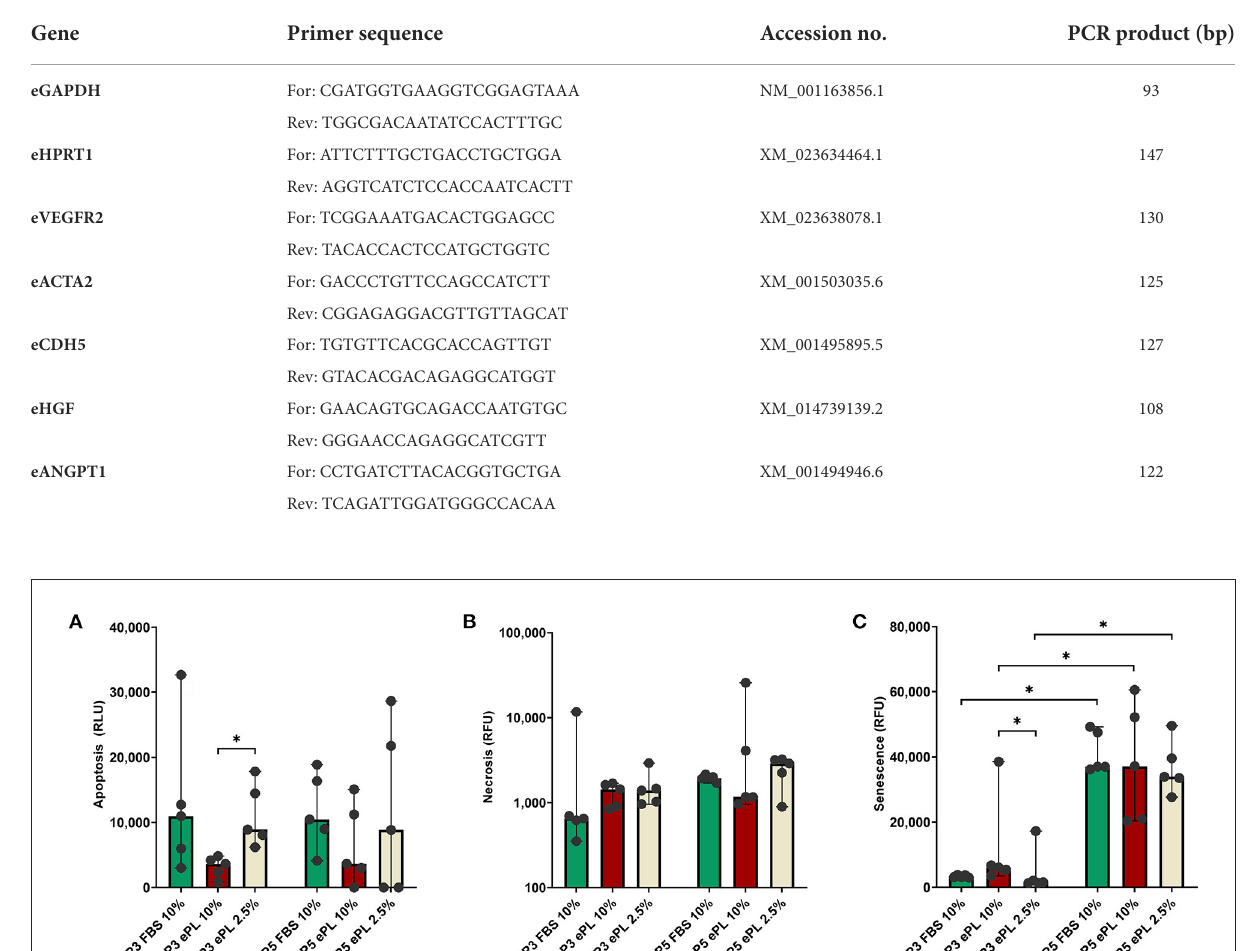
TABLE 1 Equine primers for real-time PCR.